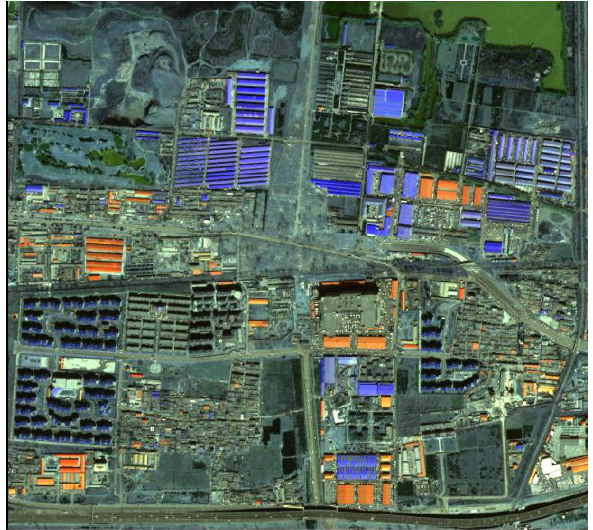
Figure 2. GeoEye-1 High-resolution Satellite